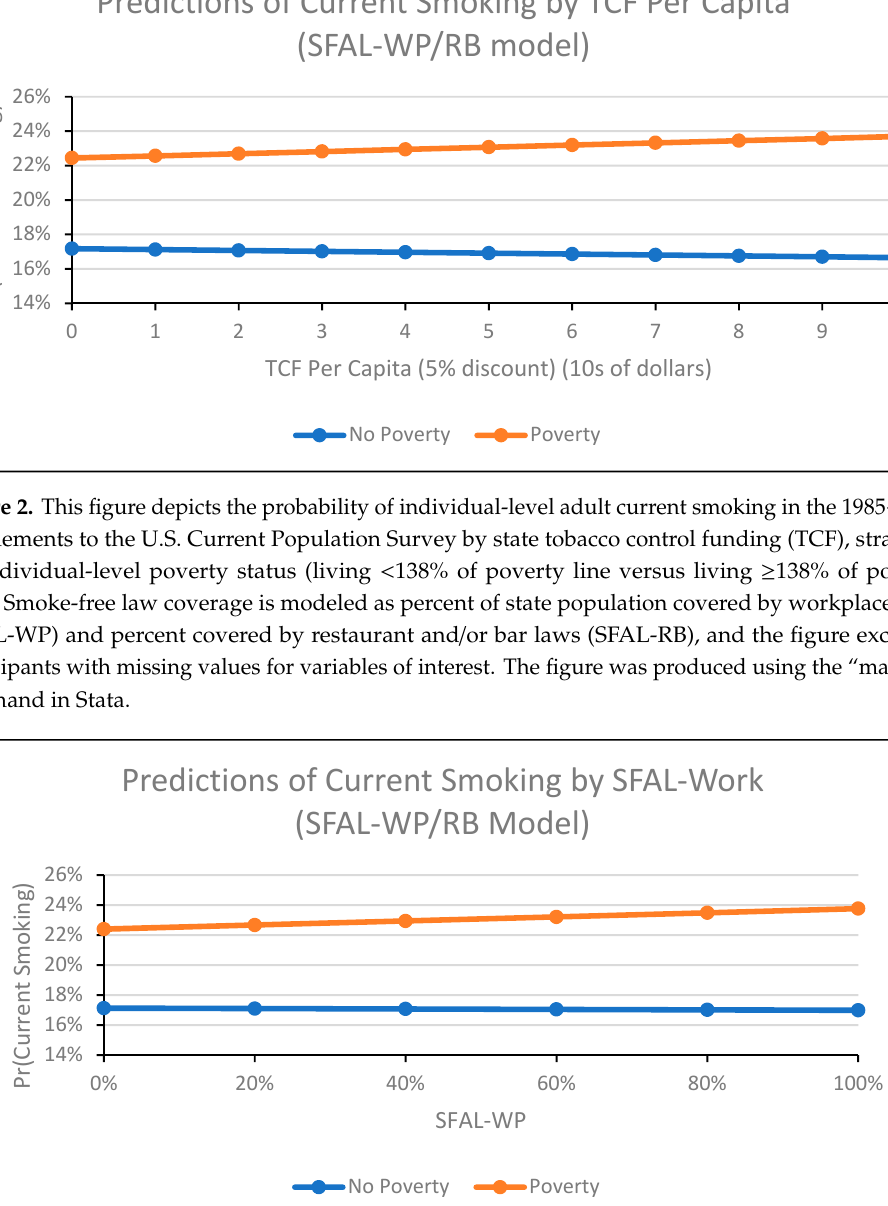
Figure 3. This figure depicts the probability of individual-level adult current smoking in the 1985 − 2015 supplements to the U.S. Current Population Survey by percent of state population covered by workplace smoke-free laws, stratified by poverty status (living < 138% of poverty line versus living ≥ 138% of poverty line). Smoke-free law coverage is modeled as the percent of state population covered by workplace laws and percent covered by restaurant and / or bar laws, and the figure excludes participants with missing values for variables of interest. The figure was produced using the “margins” command in